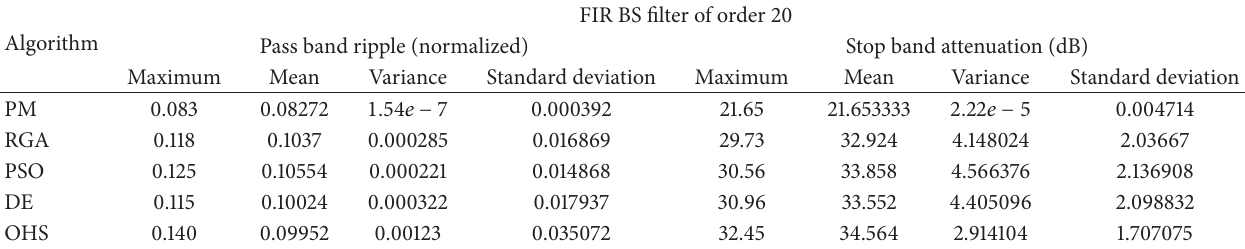
Table 14: Statistical parameters of FIR BS filters for different algorithms.